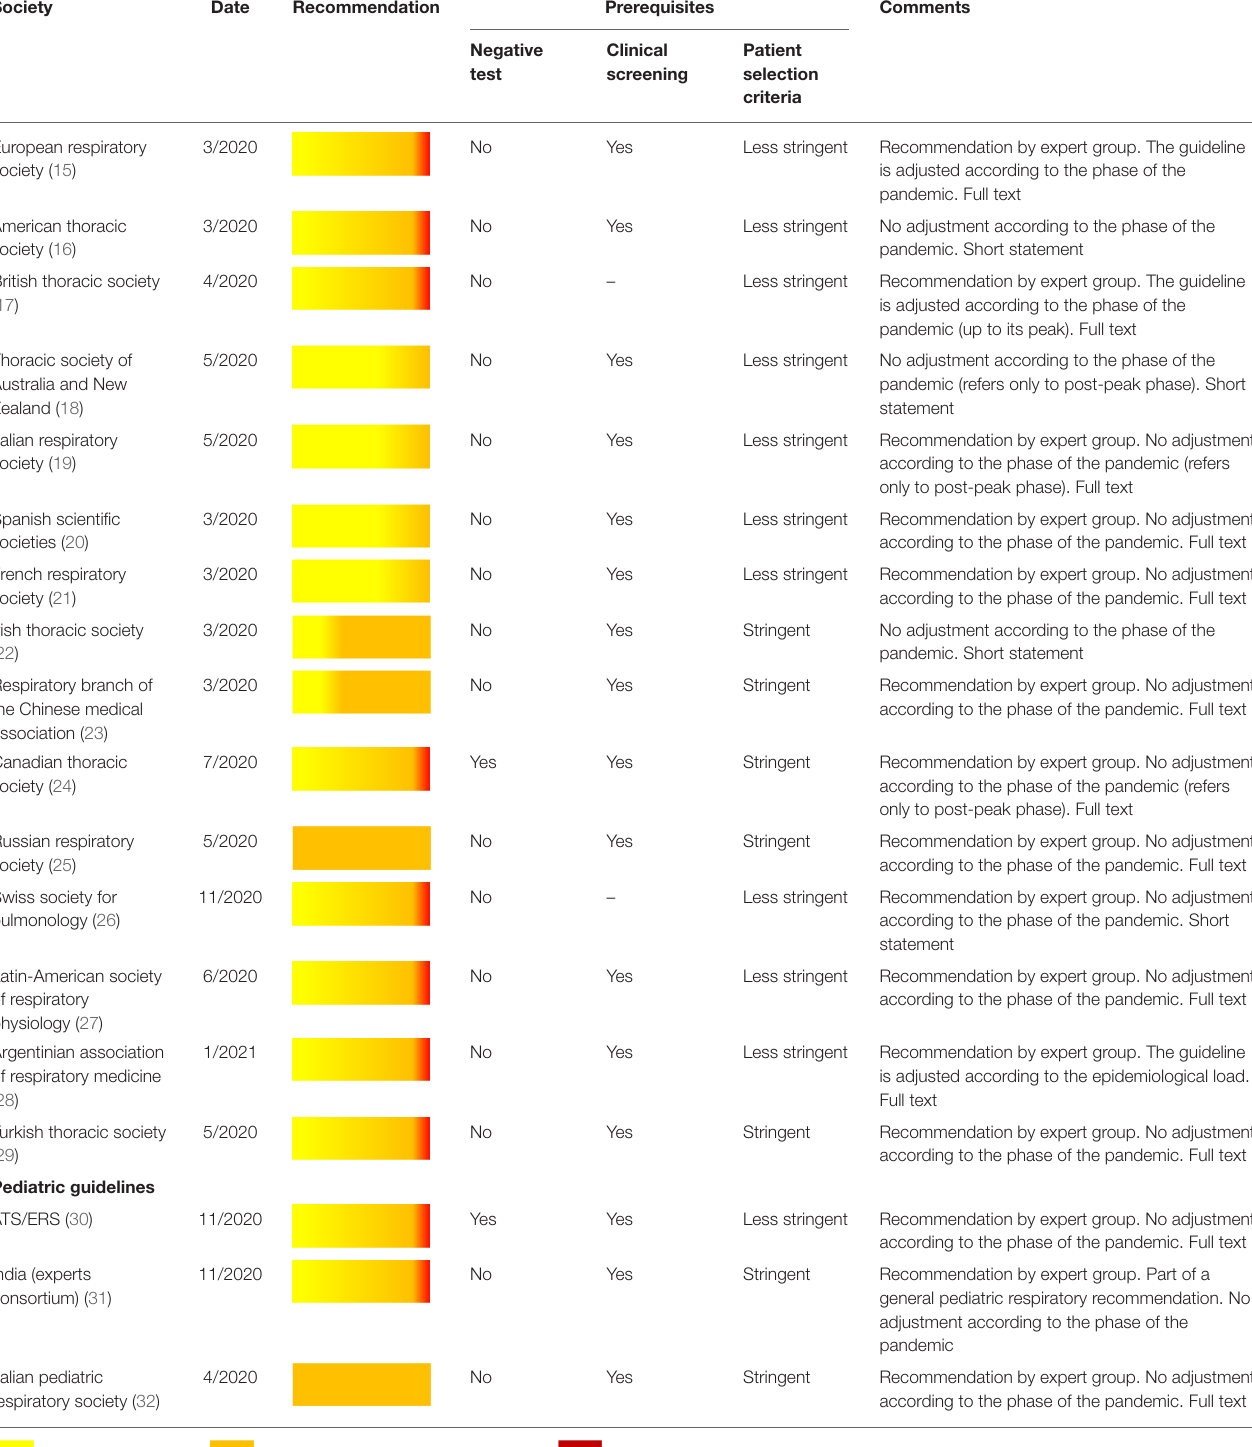
TABLE 2 | National and international recommendations on performing PFTs during the COVID-19 pandemic.